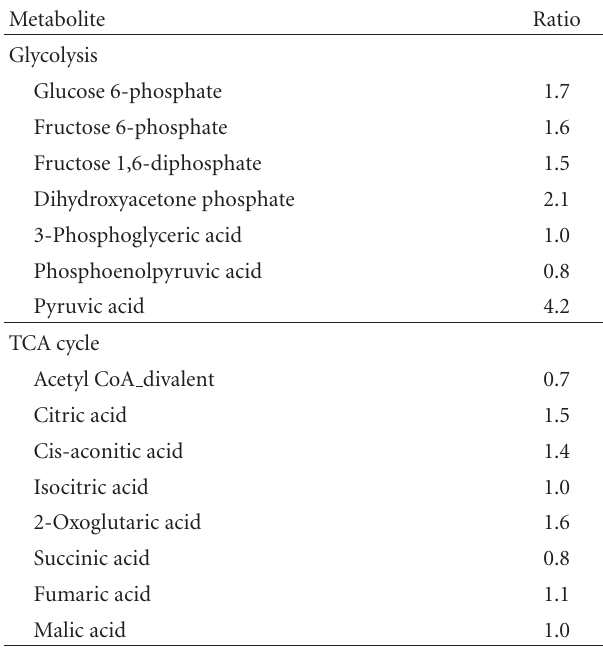
Table 2: E ff ect of C. monspeliensis extract on the metabolomics by Caco-2 cells. Quantified levels of metabolites involved in glycolysis pathway were determined. Caco-2 cells were treated with 0.1% (w/v) C. monspeliensis extract for 12 h. The ratio of quantified levels of metabolites was calculated by Caco-2 cells treated or nontreated with C. monspeliensis